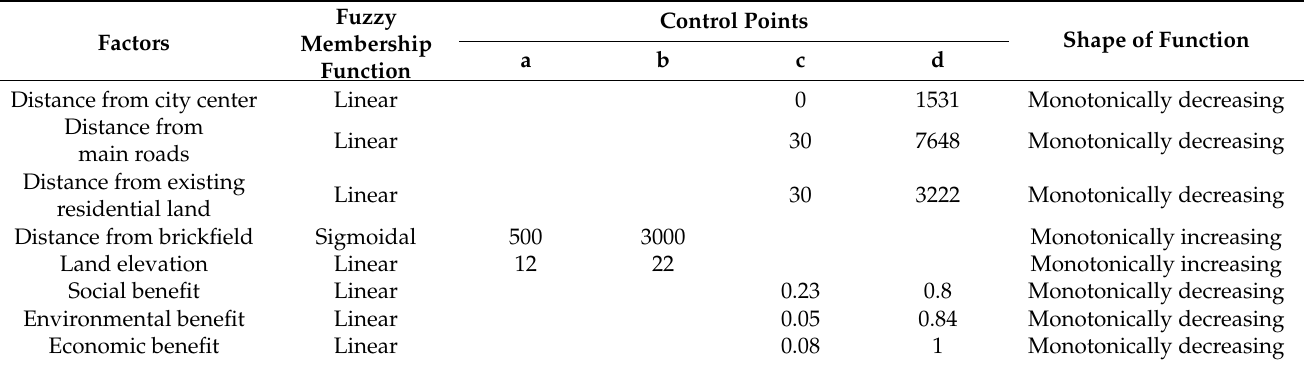
Table 2. The factors, fuzzy membership function, control points, and shape of the function used in this